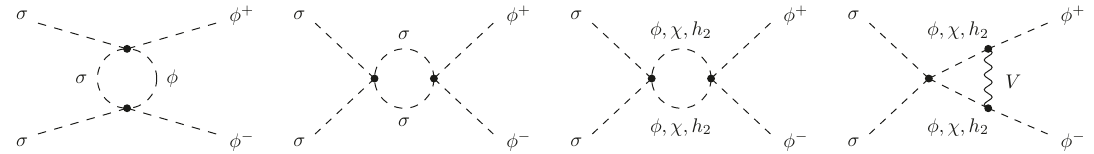
Figure 4 . UV-divergent diagrams contributing to the (cid:27)(cid:27)(cid:30) + (cid:30) (cid:0) vertex correction in the unbroken phase of the SESM, with V denoting the EW gauge bosons. For the (cid:12)rst diagram, a crossed version exists as